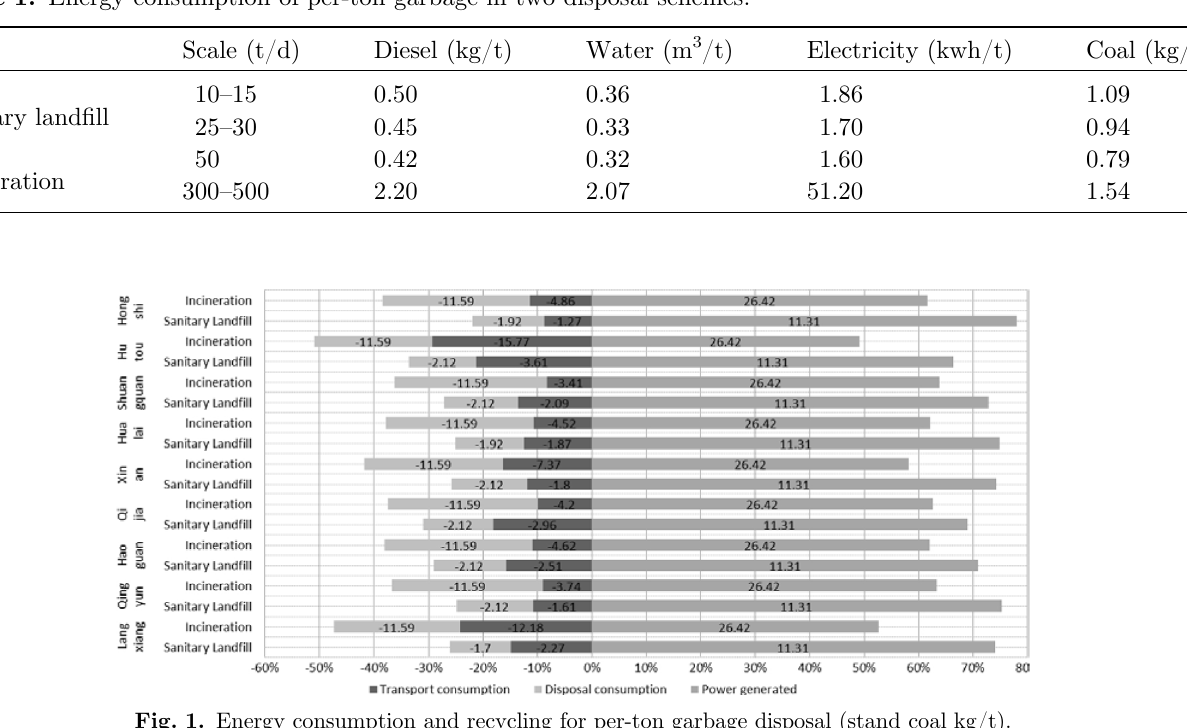
Table 1. Energy consumption of per-ton garbage in two disposal schemes.